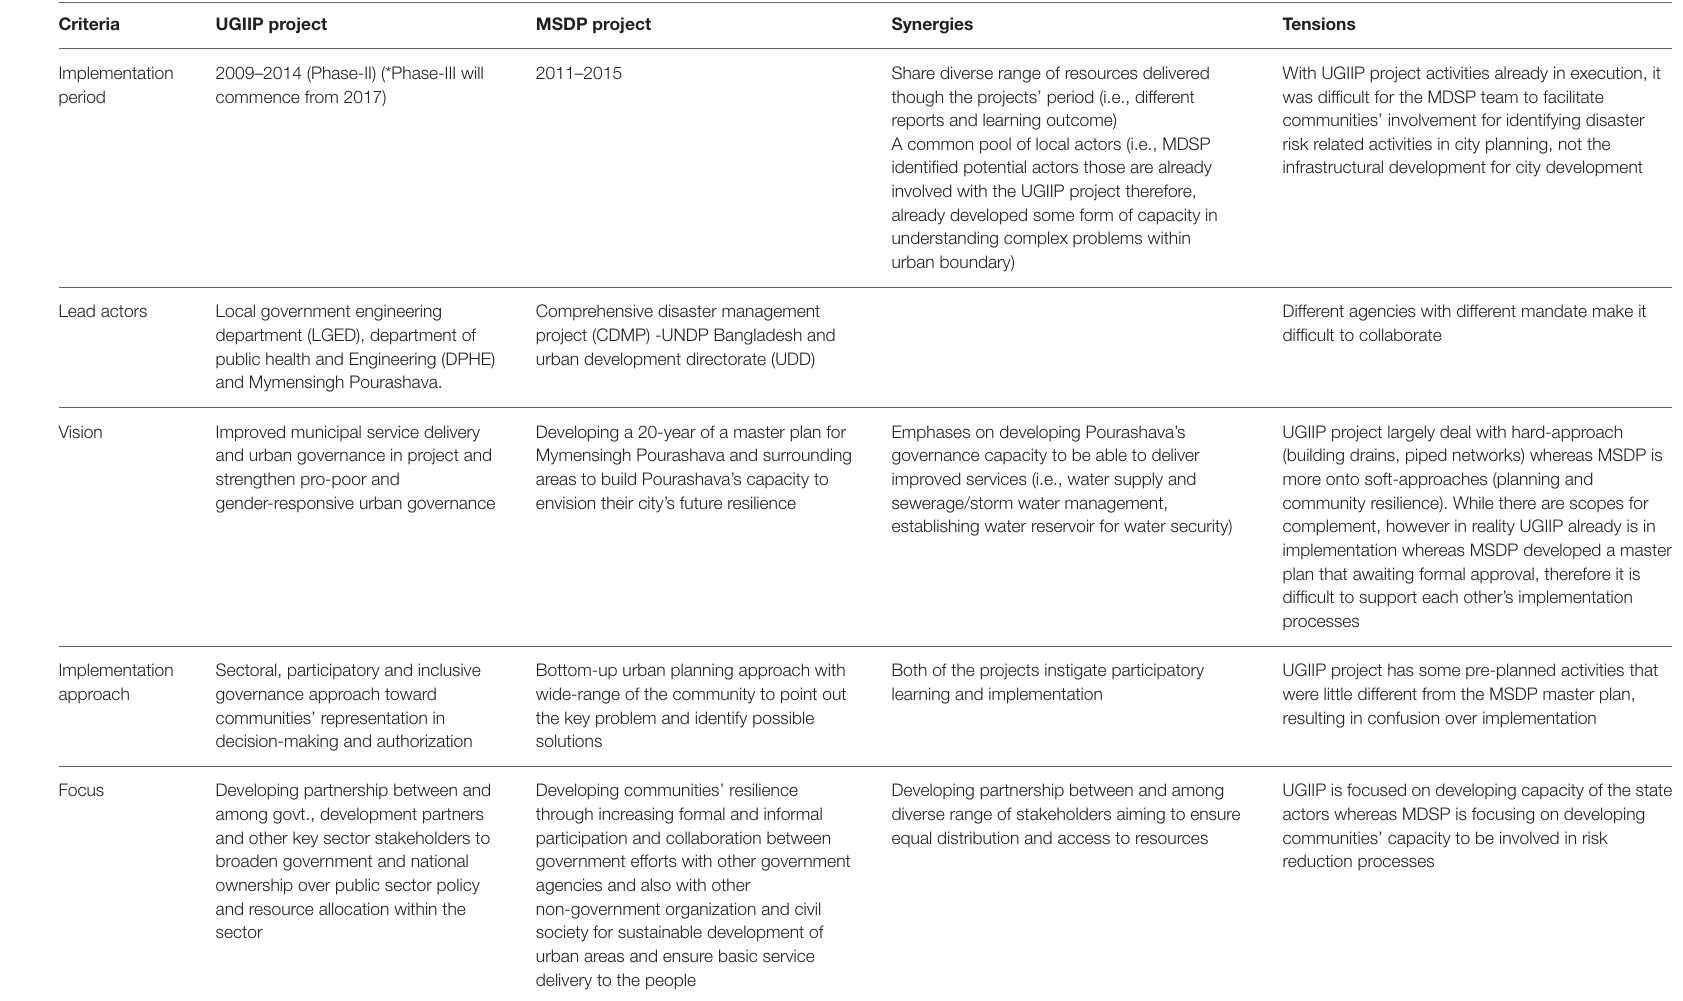
TABLE 3 | Synergies and tensions between the UGIIP and MSDP projects in Mymensingh.